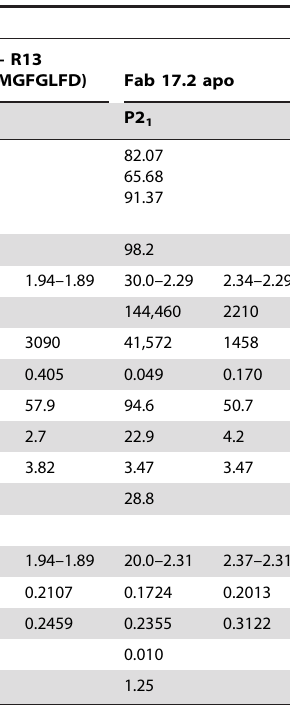
Table 1. Crystallographic data and refinement